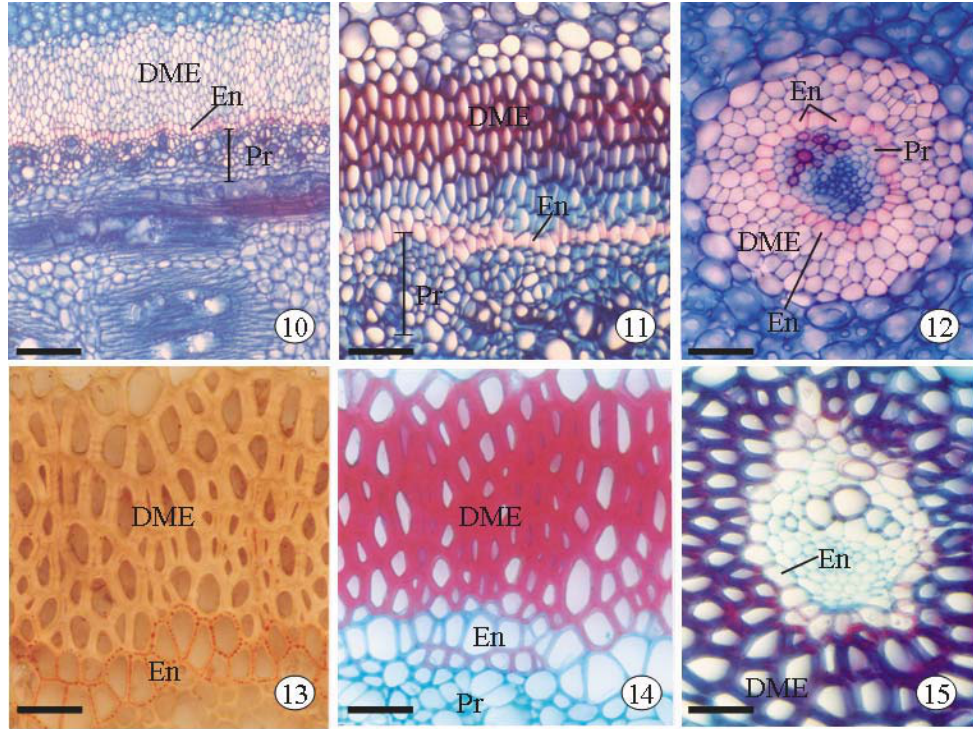
Fig. 10-15 – Cyperus papyrus . Different levels of transverse sections of the rhizome, one noting the endodermis (En) in Fig. 10, with suberize walls (better observed in Fig. 13). The DME (Derivatives of the Meristematic Endodermis) cells are not thickened (Fig. 10). At the level presented in Fig. 11, the progressive thickening of the walls of DME cells can be seen, and in Fig. 12, a leaf trace in the cortex of rhizome, at the corresponding level in Fig. 10, also presents derivatives of the meristematic endodermis (DME). Fig. 13 shows the result of the reaction with Sudan IV. Fig. 14 – Note the completely thickened DME layers, and at the same level, the leaf trace (Fig. 15) with thickened DME cells. Pr – pericycle. The bars correspond respectively to: 200 µ m, 100 µ m, 100 µ m, 50 µ m, 50 µ m and 50 µ